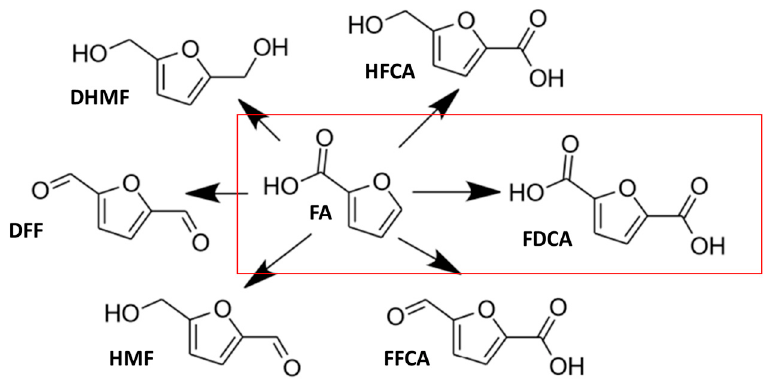
Figure 2. Possible carboxylation reaction routes from furoic acid (FA) to 2,5-furandicarboxylic acid (FDCA), 5-hydroxymethylfurfural (HMF), 2,5-dihydroxmethylfuran (DHMF), 5-hydromethyl-2- furancarboxylic acid (HFCA), 2,5-diformylfuran (DFF) and 5-formyl-2-furancarboxylic acid (FFCA).